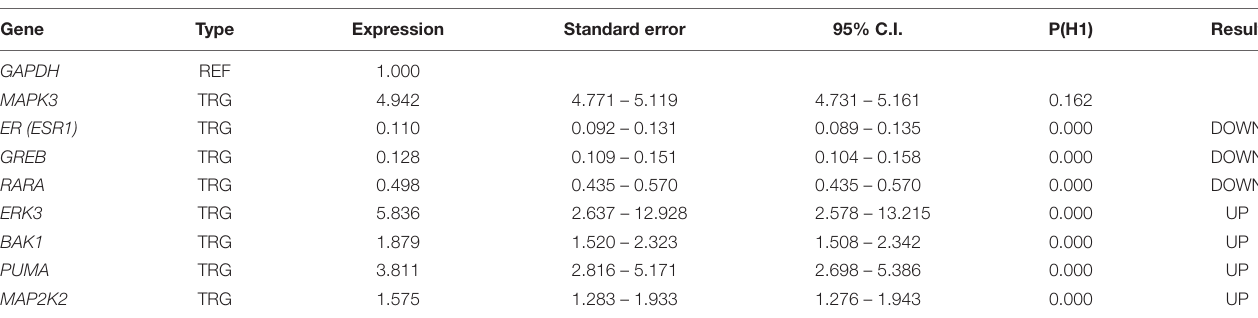
FIGURE 7 | Analysis of the expression level of intended DEGs using qPCR. Bak1 , PUMA , ERK3 and MAP2K2 genes were overexpressed in tamoxifen-treated MCF-7 cancer cells, while the expression level of MAPK3 was not significantly changed. On the contrary, ER (ESR1) , GREB and RARA were depressed under tamoxifen induction. Each value is the mean ± SD of three separate experiments. The statistical significant differences are indicated with ∗ for p < 0.05. TABLE 2 | qPCR analysis of the desired